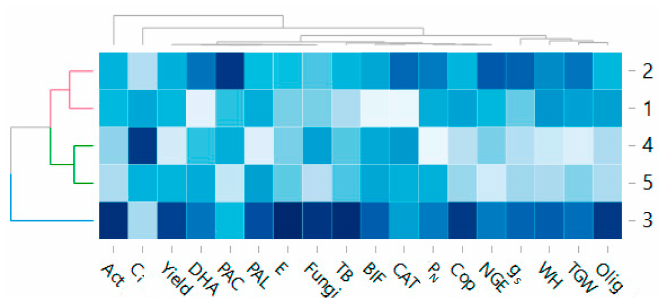
Figure 7. A comparable reaction between microbiological activity and gas exchange parameters